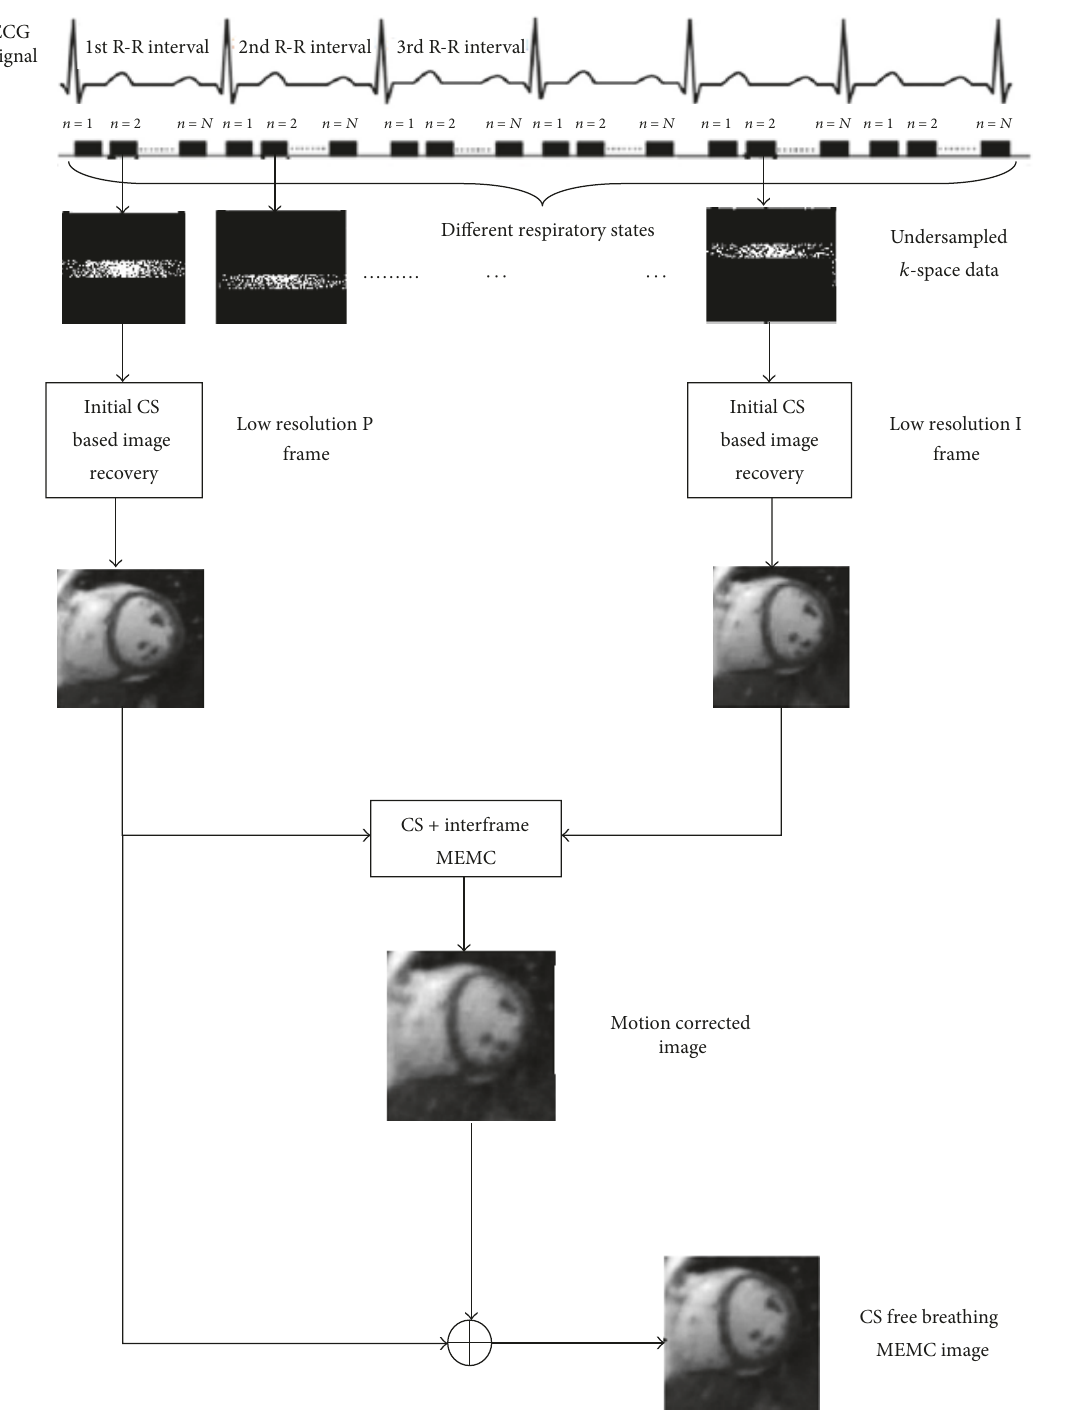
Figure 1: A presentation of initial CS recovery and CS-MEMC recovery steps of the proposed method. For simplicity, only two heart phases with different respiratory states are shown with six heart beats and 𝑁 cardiac phases. Low resolution P and I frames are generated primarily by CS. Using ARPS block matching algorithm, motion is estimated and corrected to produce a motion corrected image. The CS-free breathing MEMC image is generated by combining a low resolution P frame and motion corrected